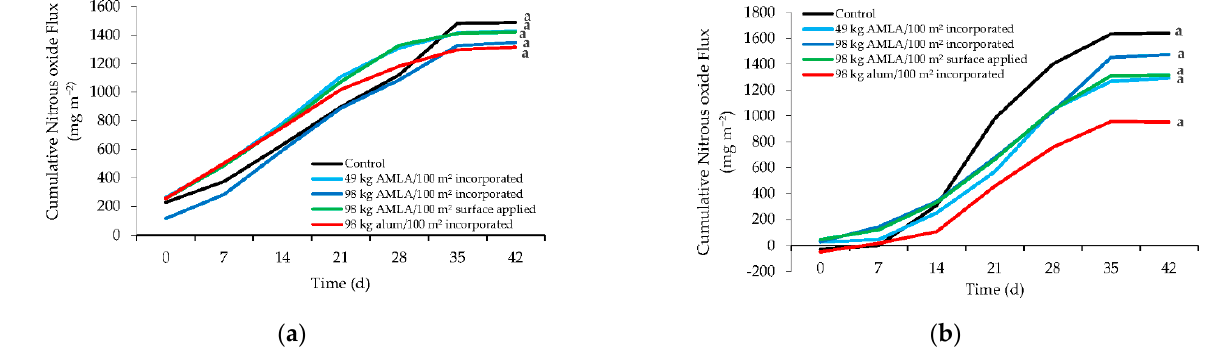
Table 2. Average litter moisture (%) flock 2 and 3 by treatment by day.